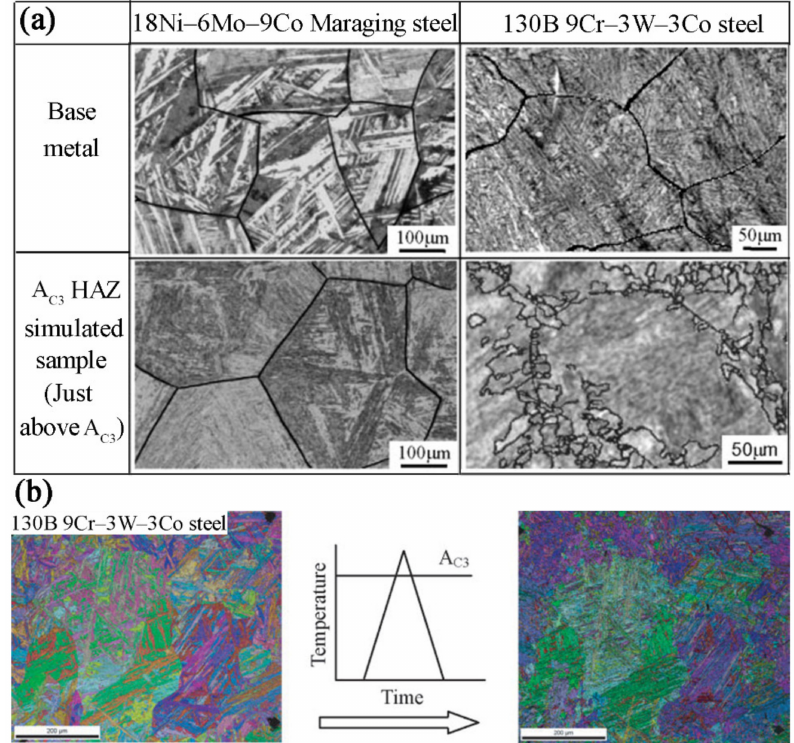
Figure 4. Microstructure of base metals and simulated A C3 HAZs of 18Ni–6Mo–9Co maraging steel and NIMS 130B 9Cr–3W–3Co steel [70]: ( a ) Scanning electron microscopy (SEM) images and ( b ) EBSD